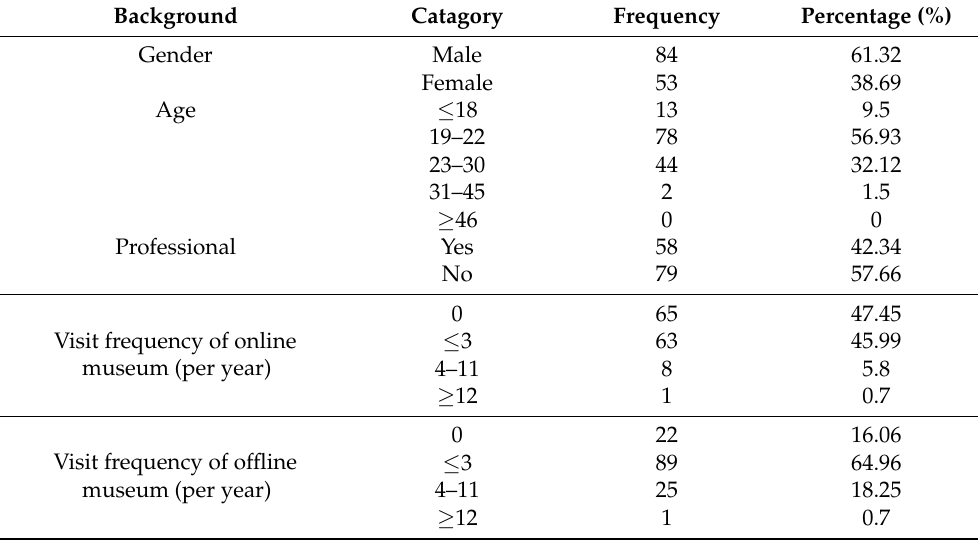
Table 5. Participant’s sociodemographic features [( n =